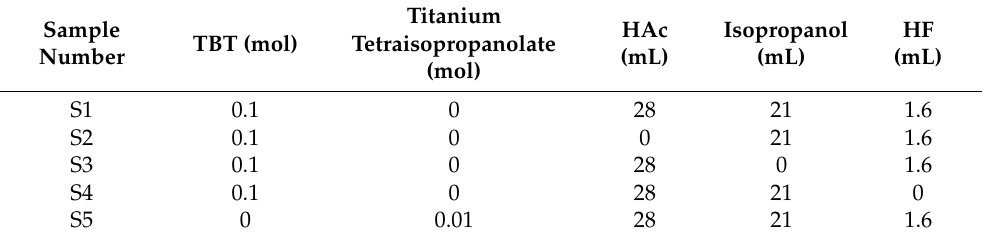
Table 1. The composition of the solvent under different reaction